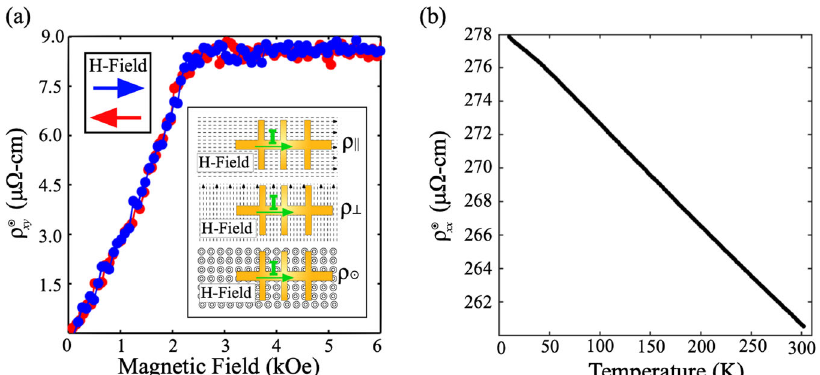
Fig. 1 Transport properties of the Fe/Gd patterned wire. a Field-dependent polar Hall resistivity ( ρ (cid:1) xy ) obtained at room temperature for the 10 μ m-wide Fe/Gd patterned wire. The ρ (cid:1) xy is color-coded to show fi eld-dependent responses: (red-colored) positive-to-negative saturation, while (blue-colored) negative-to-positive saturation. The magnetic fi eld was swept from H z = ±10 kOe, but for ease of viewing a smaller fi eld range is shown. The inset in a shows the magnetic fi eld and current con fi gurations used to measure the response of the Fe/Gd patterned wire. b The temperature-dependent polar longitudinal resistivity ( ρ (cid:1) xx ) of the Fe/Gd patterned wire under a zero- fi eld-cooling (ZFC) protocol; prior to fi eld-cooling, the Fe/Gd patterned wire was saturated with a perpendicular fi eld and then the fi eld was reduced to H z = 0.